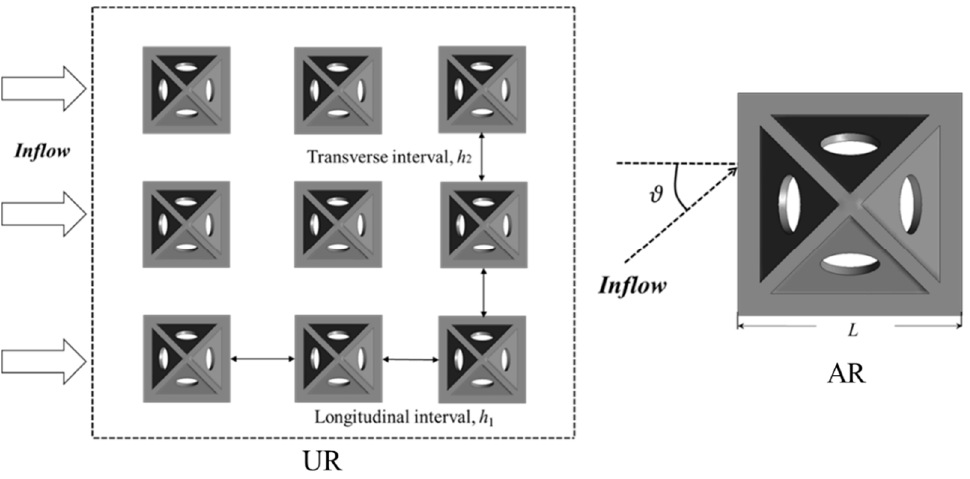
Figure 2. The UR and AI. Note: θ : angle of inflow.